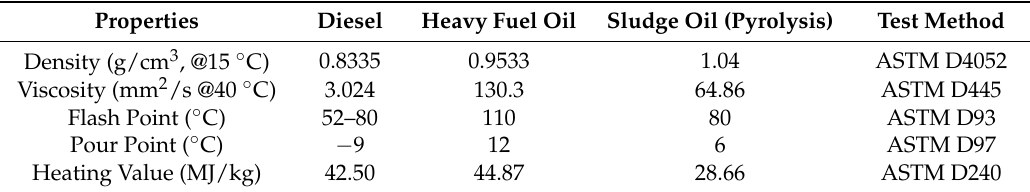
Table 7. Properties of different kinds of liquid fuels.